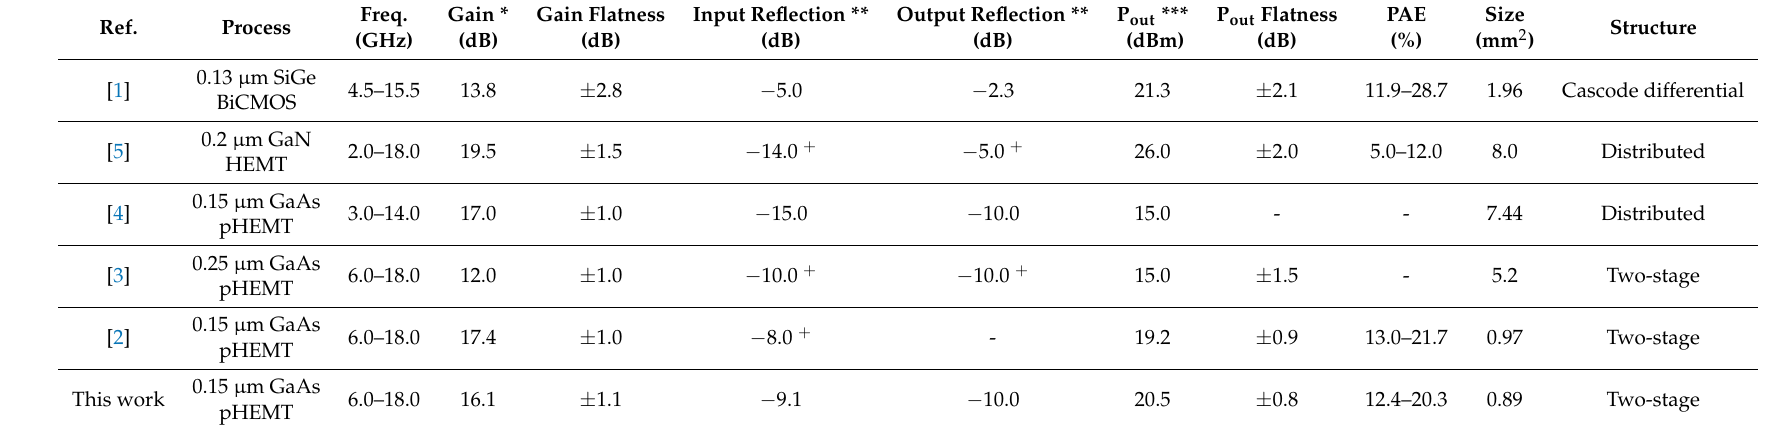
Table 2. Component values for the feedback, resistor bias, and frequency selective degeneration